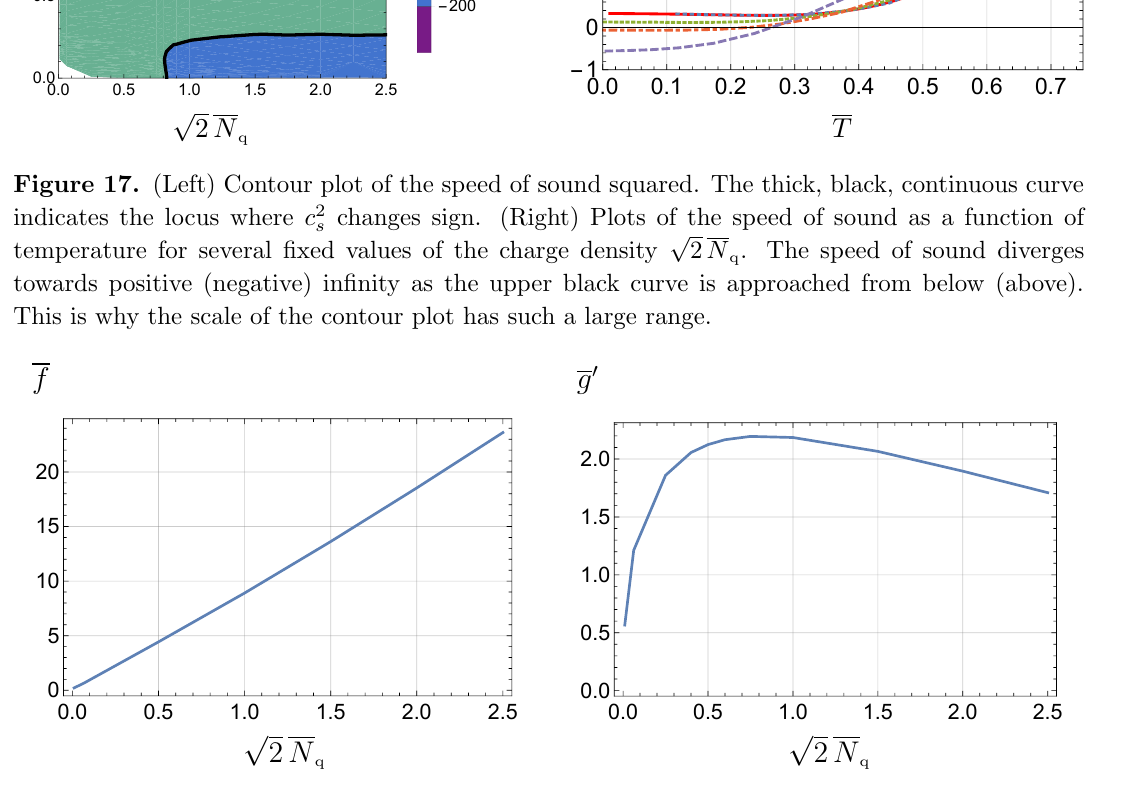
Figure 18. Functions f and g 0 de(cid:12)ned through eqs. (5.11) and (5.13) ,